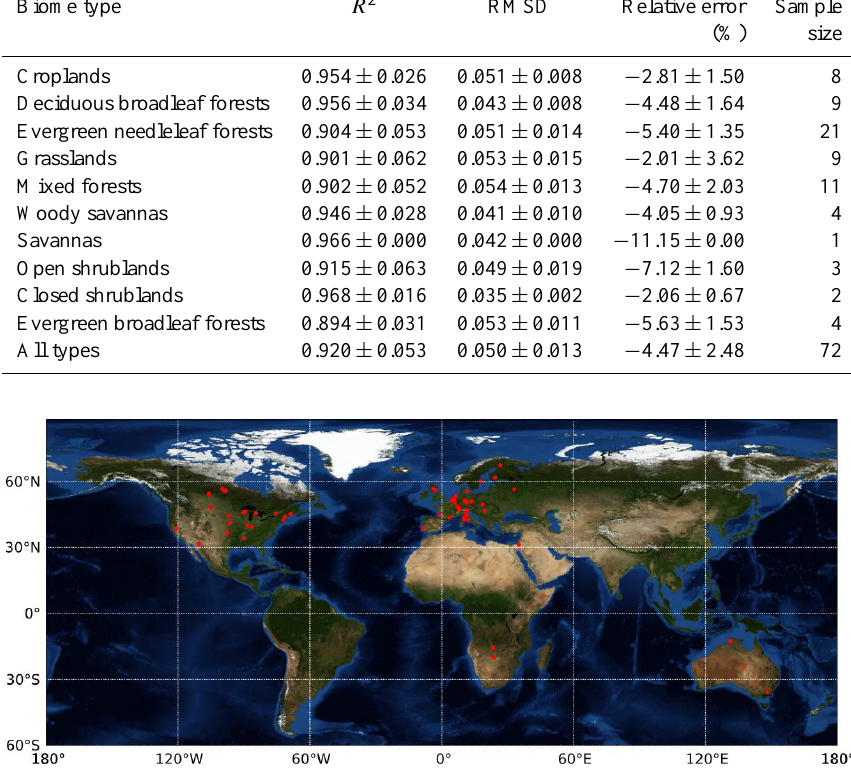
Figure 2. The locations of the seventy-two FLUXNET sites used in this study (solid red circle).